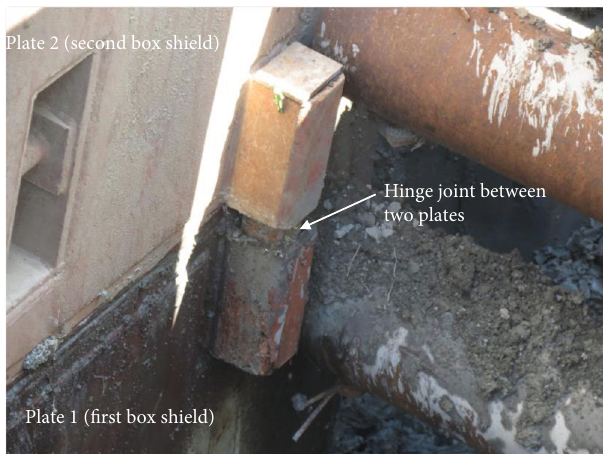
Figure 5: Experimental hinge joint between two plate walls of assembled box shields (stacked upon each